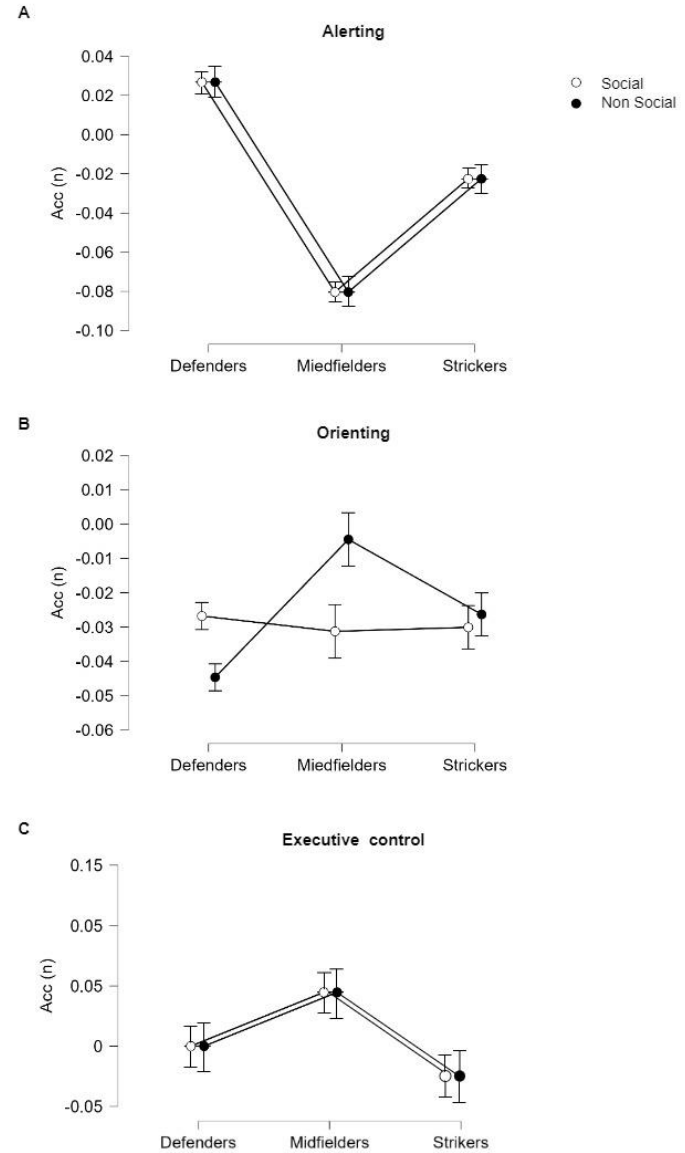
Figure 3. Accuracy variations in ( A ) Alerting (double-cue vs. no-cue conditions); ( B ) Orient- ing (spatial-cue vs. central-cue conditions); and ( C ) Executive Control (congruent-flanking vs. incongruent-flanking conditions) are reported. On the y-axis accuracy scores (n) and on the x-axis three-level between-factor Roles (Strikers, Midfielders, and Defenders) and two-level within-factor Stimuli (Social and Non-Social) are reported with separate lines. Abbreviations: Acc = accuracy score